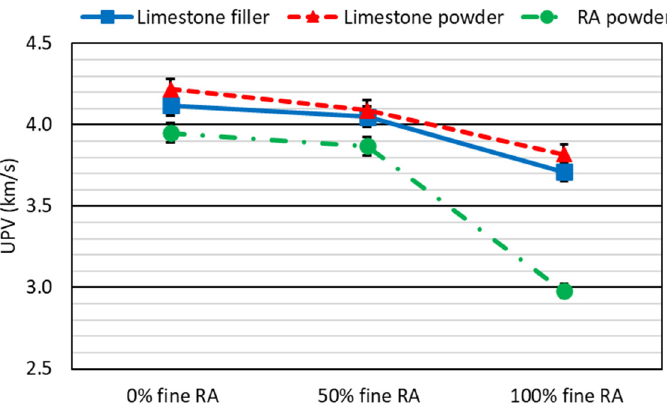
Figure 4. Ultrasonic pulse velocity (UPV) of SCC mixes.